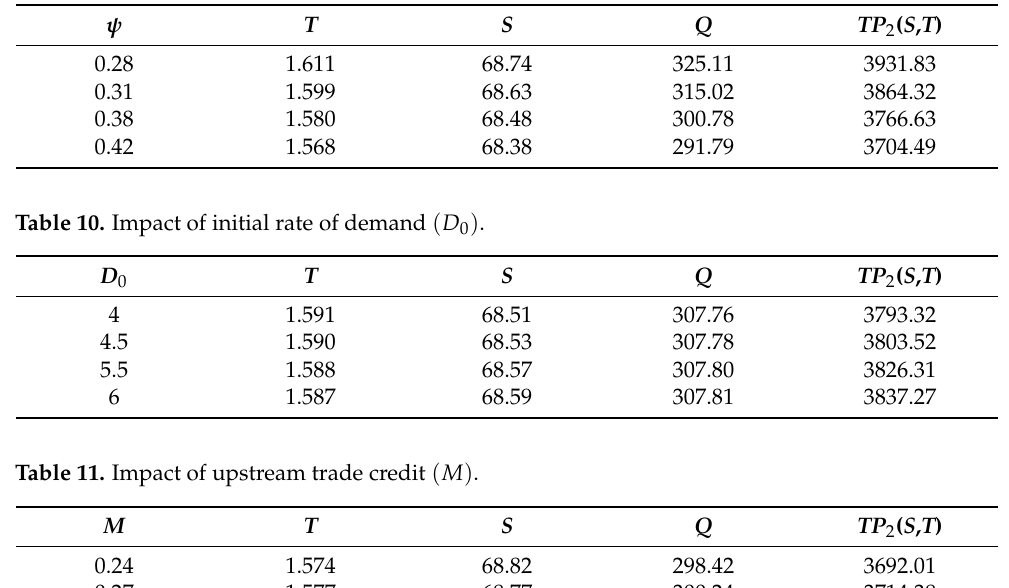
Table 9. Impact of the reduced rate of sales ( ψ ) .